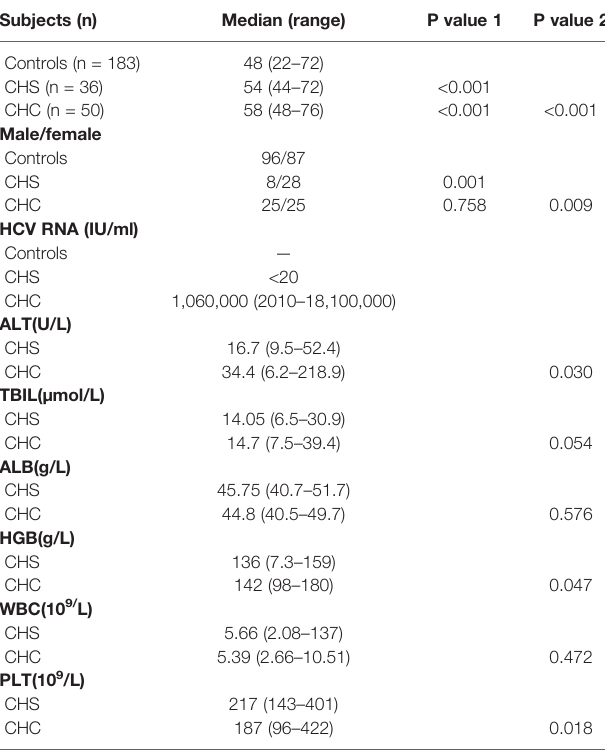
TABLE 1 | Demographic and clinical information of patients and